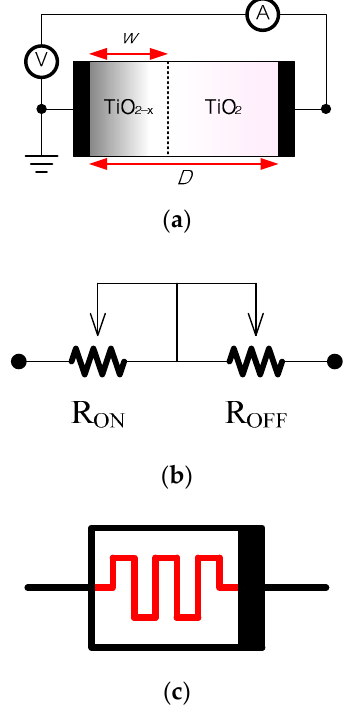
Figure 3. ( a ) Structure of TiO 2 memristor, TiO 2 − x and TiO 2 layers are sandwiched between two platinum electrodes. When a voltage/current is applied, its memristance is altered; ( b ) equivalent circuit and ( c ) symbol of the Memristor.